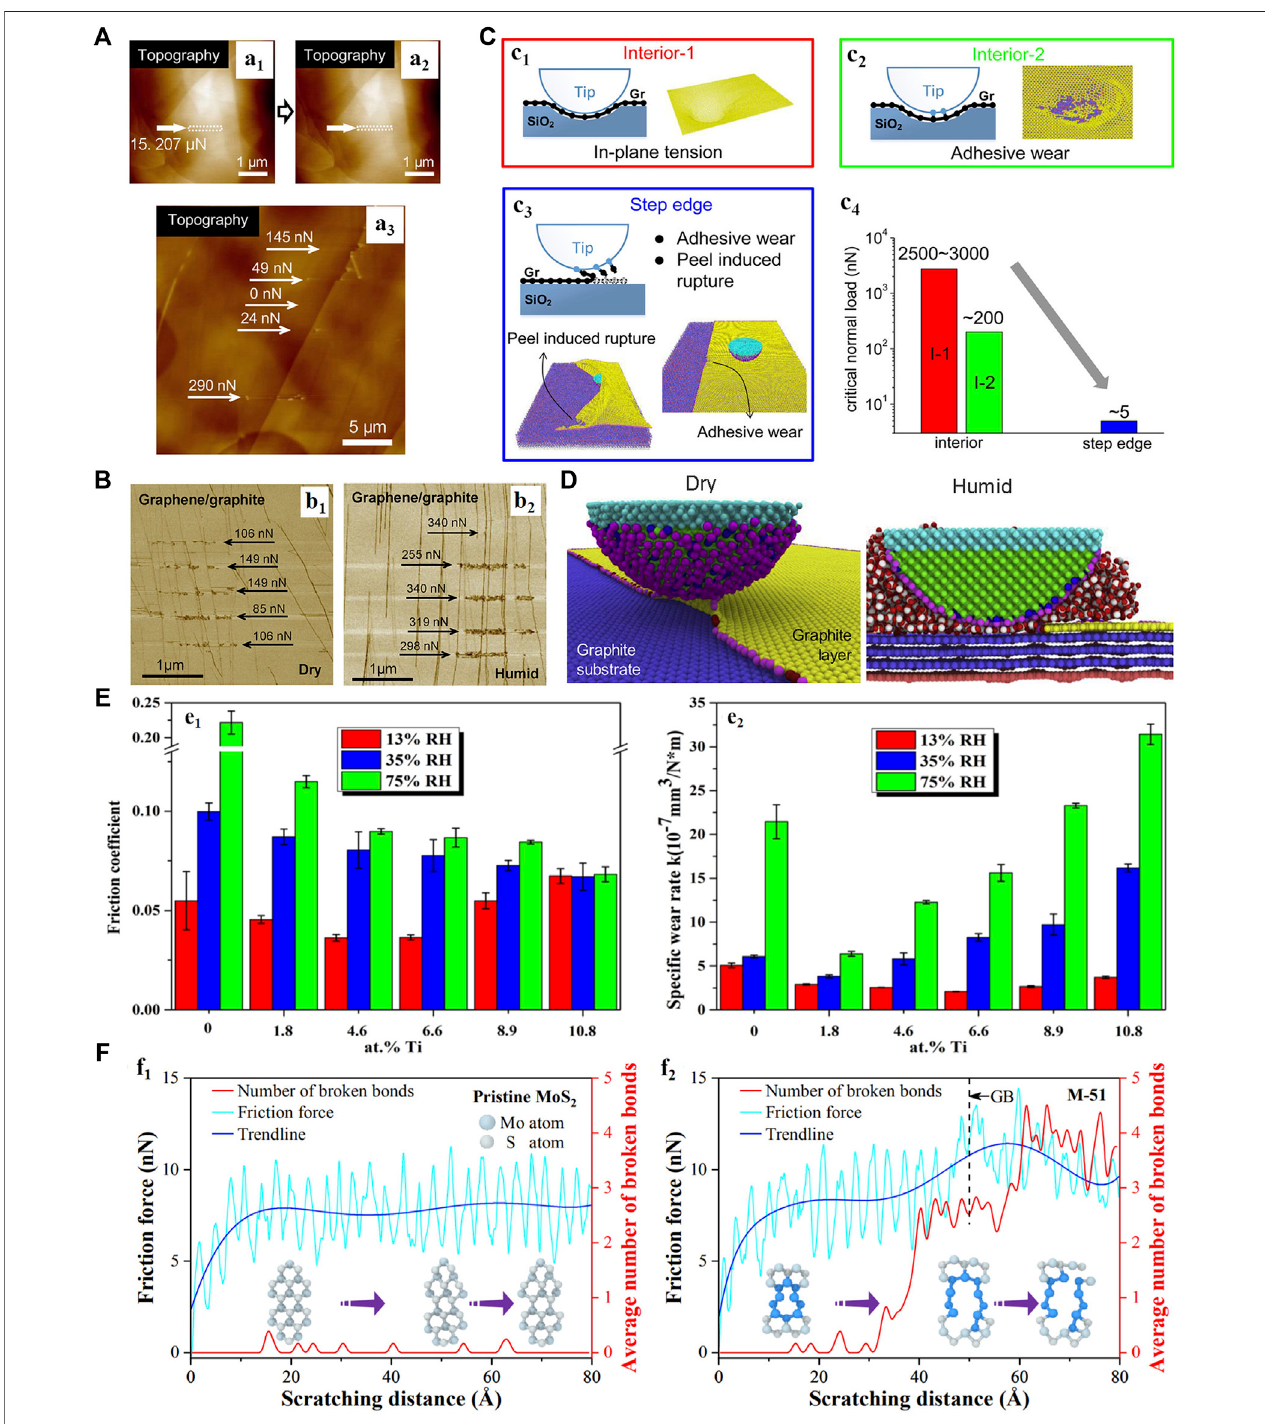
FIGURE 1 | (A) Comparative scratch tests of graphite in the interior region and at the step edge of the graphene monolayer. No remarkable changes in the topographiesbefore(a 1 )andafter(a 2 )scratchingat15.207 μ Nindicatesnowearoccurringintheinteriorregion.Differently,thewearofthestepedgeinitiatesatanormal load of 24 nN (a 3 ). Adapted from Qi et al. (2017) (B) Scratch tests at the step edges of the monoatomic graphene layer on a graphite surface in dry (b 1 ) and humid (b 2 ) conditions. Adapted from (Qi et al., 2018) (C) MD simulations of the scratching tests showing the wear of in-plane graphene with tension damage (c 1 ) or with abrasivewear(c 2 )initiationatmuchlargercriticalloads(c 4 )comparedtothefractureofthestepedge(c 3 ).AdaptedfromQietal.(2017) (D) MDsimulationsofscratchinga diamondtipacrossthe stepedgeofthemonoatomicgraphenelayeron agraphitesubstrate.Adapted fromQiet al.(2018) (E) Frictioncoef fi cient and wearrateofMoS 2 and MoS 2 /Ti composite coatings in different humidity. Adapted from (Li H. et al., 2017) (F) MD simulations about the change of friction force and the average number of broken Mo-S bonds during the scratching process of the MoS 2 without (f 1 ) and with (f 2 ) defects. Adapted from Wei et al. (2021).